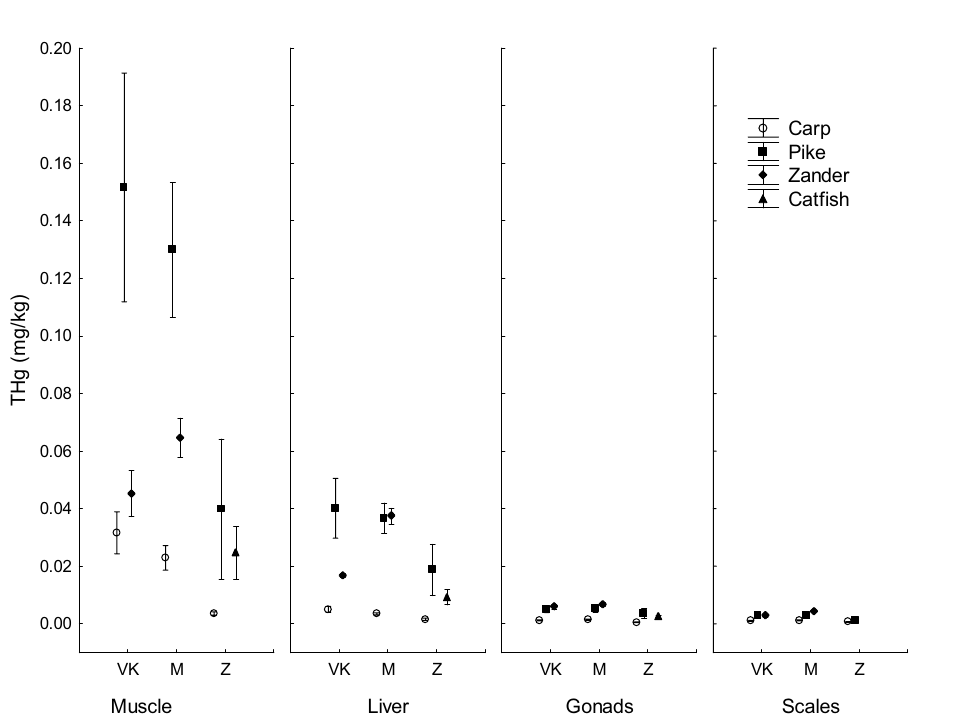
Figure 2. Total mercury content (mg/kg wet weight) in fish tissue of carp, pike, zander and catfich caught in three sampling sites: Velky Kocelovicky (VK), Mysliv (M) and Zehunsky (Z). Vertical bars denote 0.95 confidence